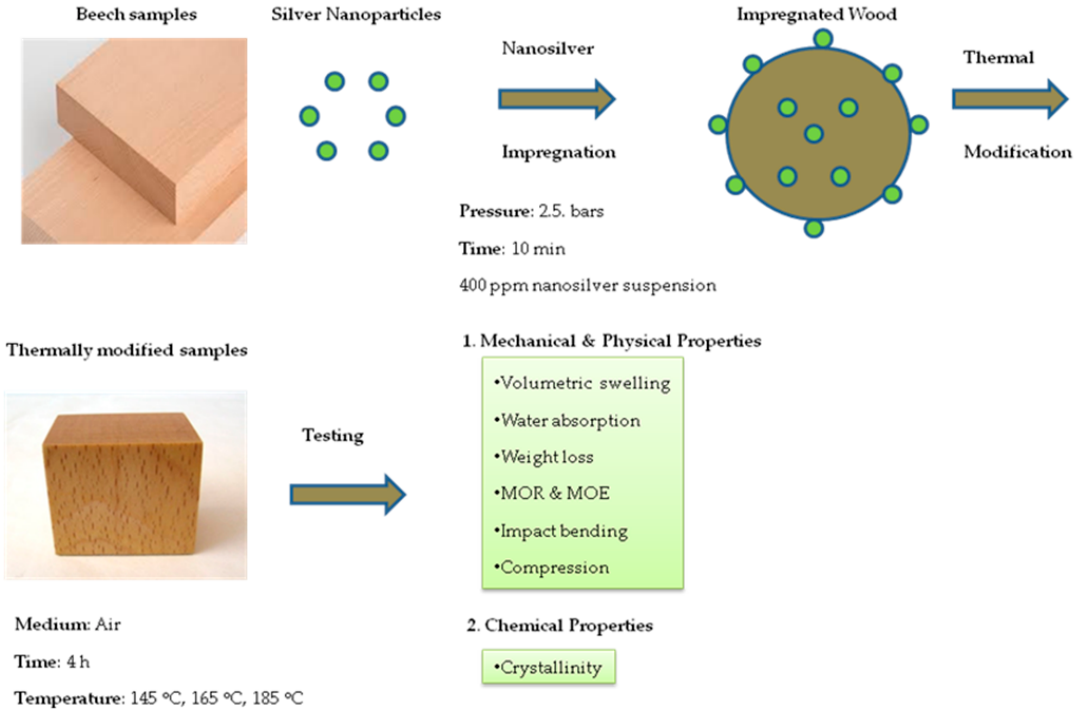
Figure 1. Flow diagram of the experimental